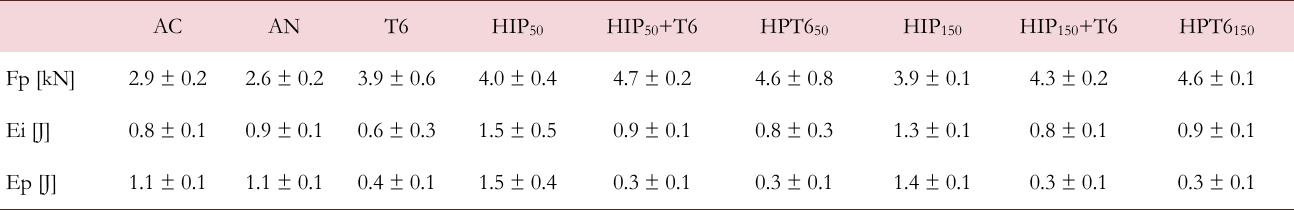
Table 3: Force-displacement results of all the tested specimens, where Fp is the peak force, Ei is the initiation energy, and Ep is the propagation